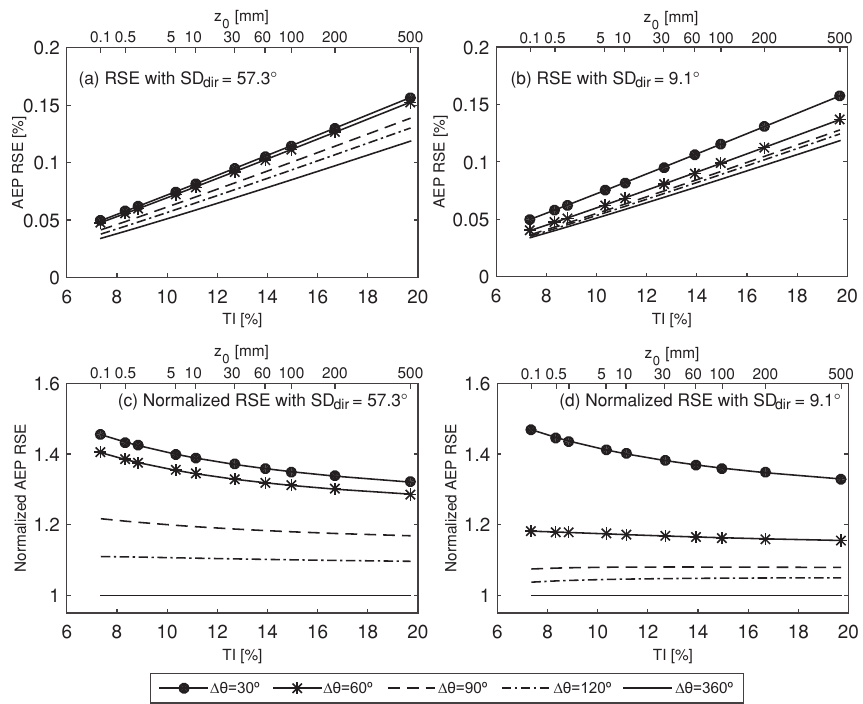
Figure 10. The relative standard error (RSE) in annual energy production (AEP) arising from arc scan velocity retrieval uncertainty as a function of turbulence intensity (TI) and surface roughness length ( z 0 ), assuming that wind speed follows a Rayleigh distribution with a mean of 7ms − 1 , and wind direction follows the von Mises distributions with a mean of 90 ◦ and standard deviations (SD dir ) of 57.3 ◦ in (a) and 9.1 ◦ in (b) . Four arc spans and a full azimuth conical scan (see the legend) are used for AEP prediction with six beams, φ = 15 ◦ and r = 315m. The normalized AEP RSE, which is the ratio of predicted AEP RSE from arc scans to that from the conical scan, is shown in (c) for SD dir = 57 . 3 ◦ and in (d) for SD dir = 9 . 1 ◦